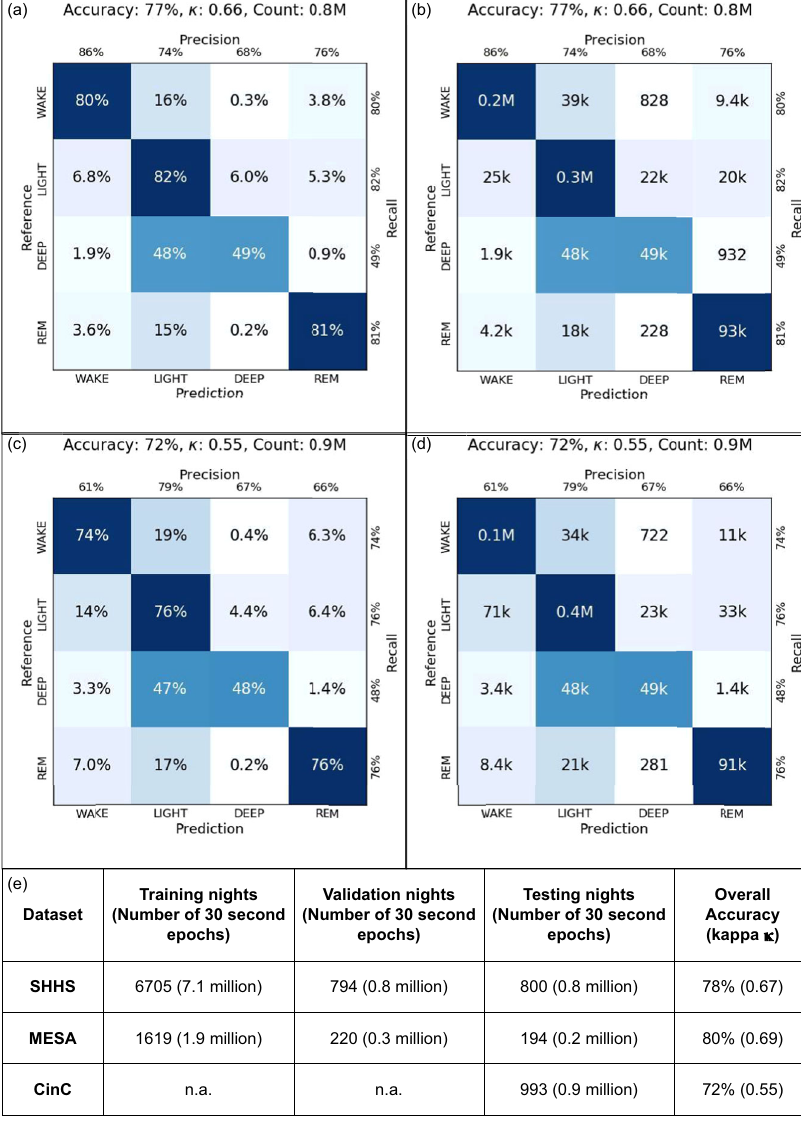
Fig. 3 Overall model performance. Confusion matrix for the SHHS dataset ( a ) normalized and ( b ) full counts. Confusion matrix for the CinC dataset ( c ) normalized and ( d ) full counts. ( e ) Dataset sizes and overall